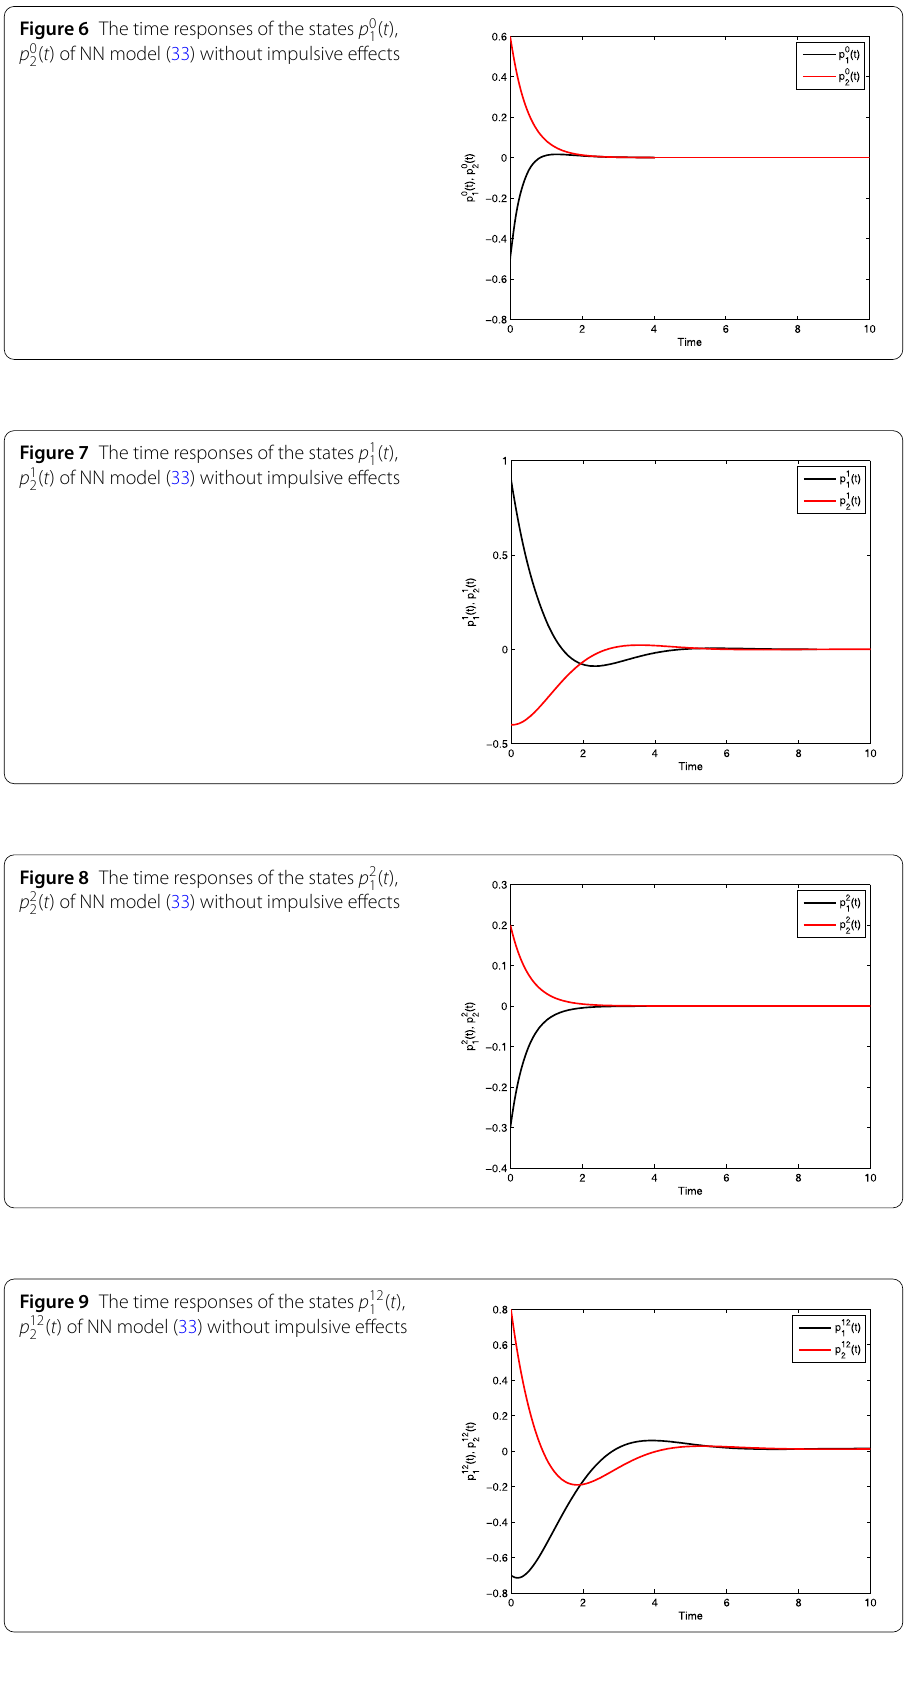
Figure 6 The time responses of the states p 0 1 ( t ), p 0 2 ( t ) of NN model (33) without impulsive effects